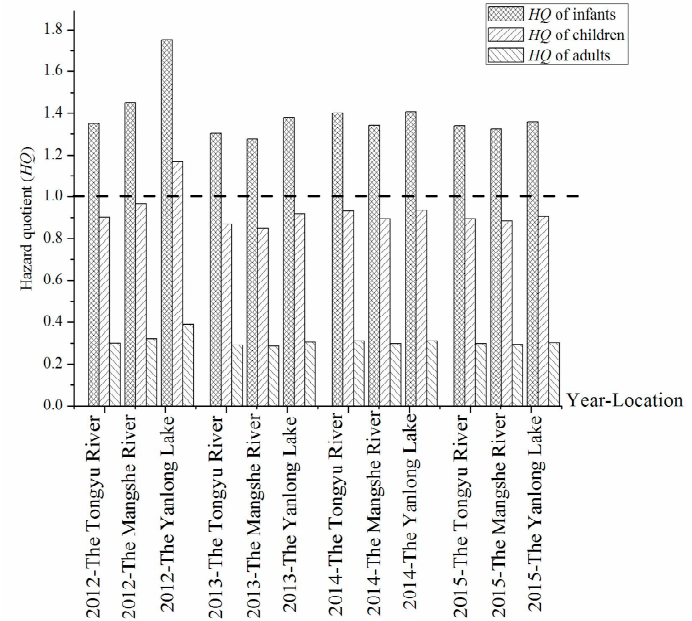
Figure 5. Hazard quotient of fluoride in the three drinking water sources from 2012 to 2015. Note: Dashed line in Figure 5 refers to the hazard quotient ( HQ ) of 1.0, which is the limit recommended by the WHO.